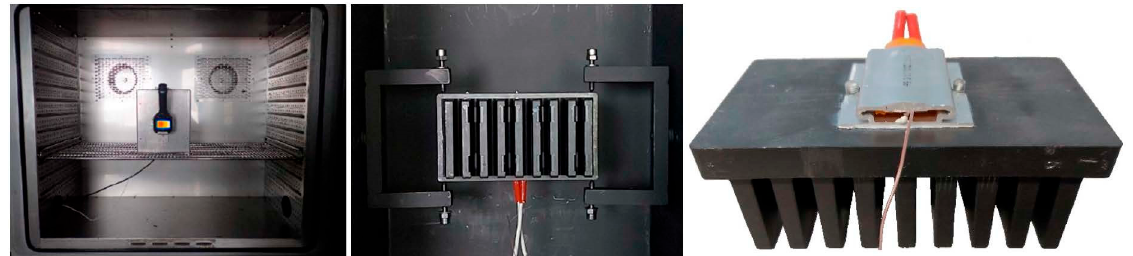
Figure 2. Measurement box inside the thermostatic chamber with attached thermal imaging camera ( left ), heat sink inside the measurement box ( middle ), attached heater with the thermocouple on the heat sink’s base ( right ).